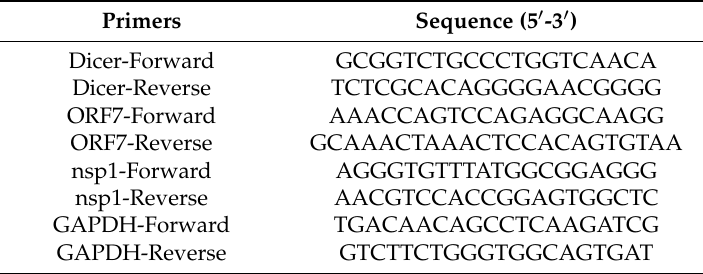
Table 1. Primers for